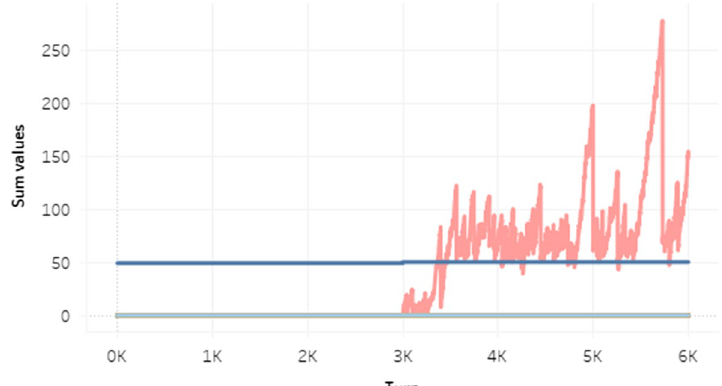
Fig. 10 Airdrop, case 2-A: Time series transition in the sum of possession of each good. Blue line is the fiat money good, red line is the cryptocurrency good, and other colors represent remaining goods. A larger amount of the cryptocurrency good exists than that of other